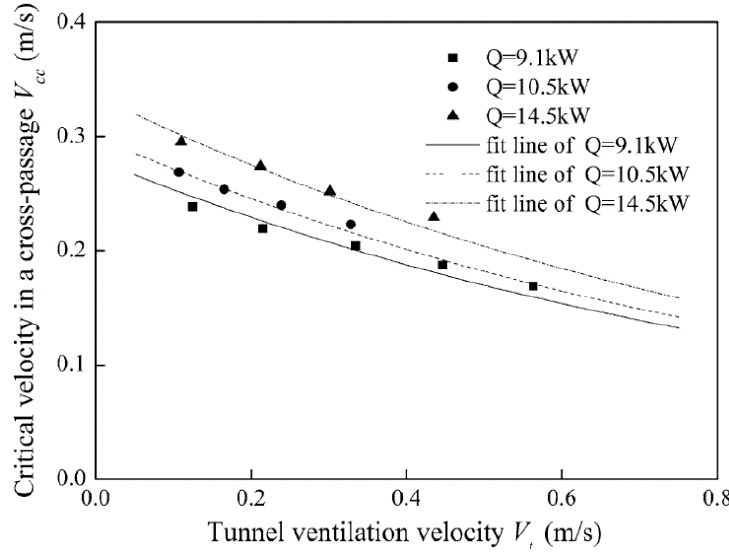
Figure 3. Critical velocity against tunnel ventilation velocity extracted from Li et al. [34]. Reprinted by permission from Springer Nature Ref [34], Copyright 2010